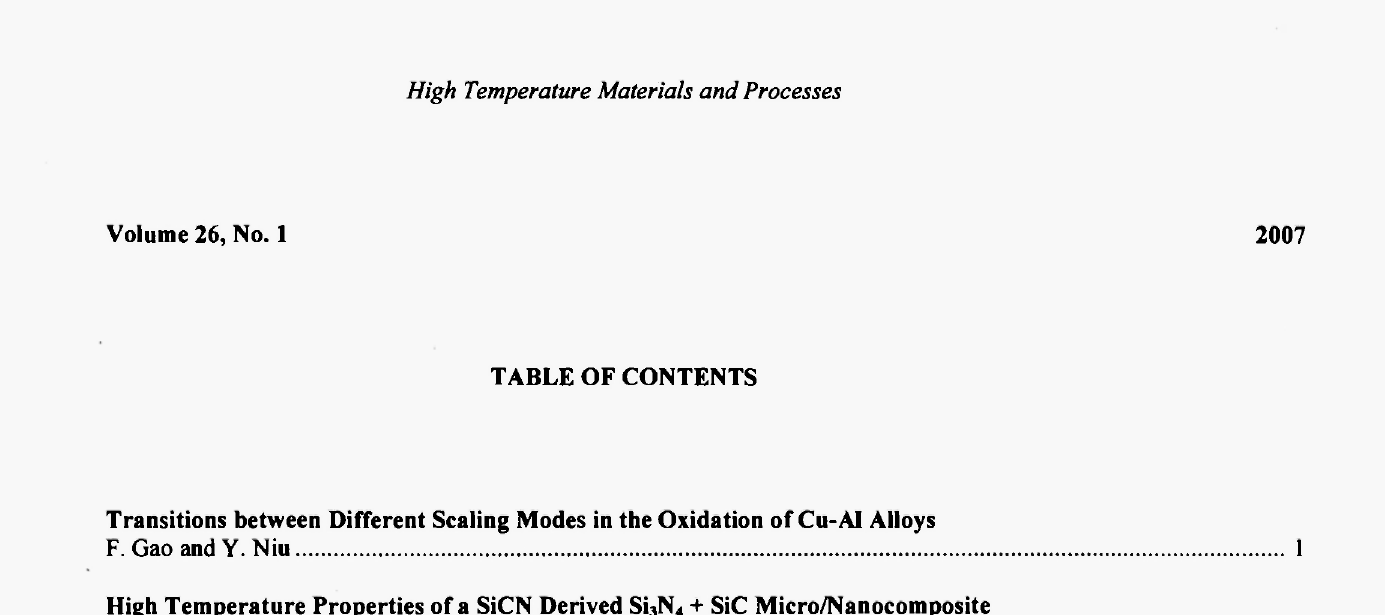
Transitions between Different Scaling Modes in the Oxidation of Cu-AI Alloys F. Gao and Y.